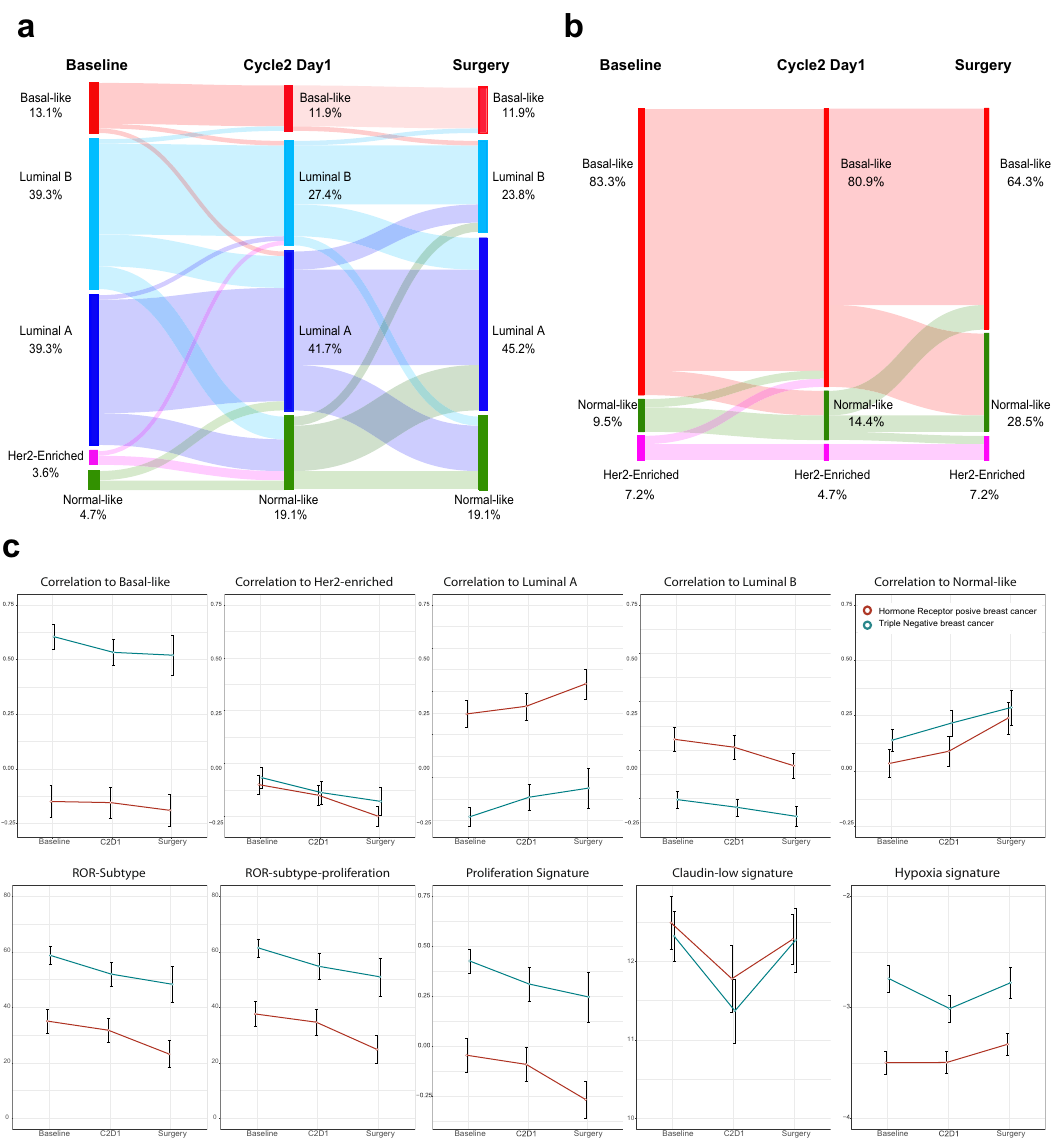
Fig. 6 Breast cancer molecular subtype shifts between baseline, cycle 2 day 1 and surgery paired samples. a Hormone receptor positives tumors. b Triple-negative tumors, c Variation of PAM50-based, claudin-low and hypoxia signatures between baseline, Cycle 2 Day 1 (C2D1) and surgery in hormone receptor-positive and triple-negative breast cancer. Error bars correspond to standard error of the